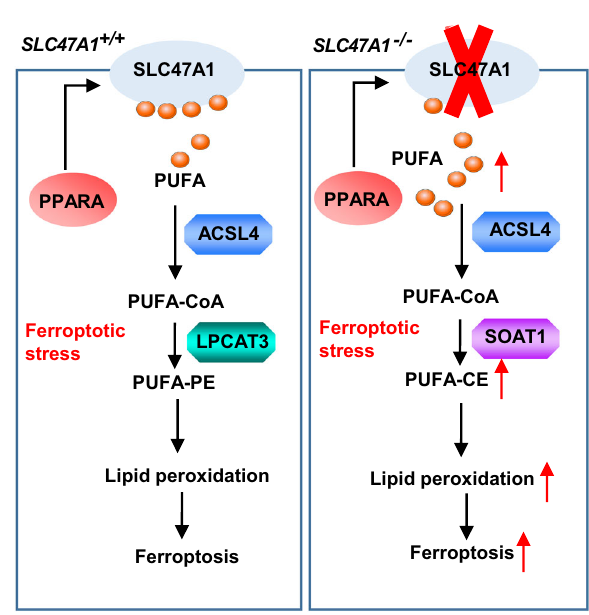
Fig. 8 | A model illustrating the metabolic role of SLC47A1 in inhibiting fer- roptosis. PPARA-mediated expression of lipid fl ipase SLC47A1 on cell membranes is a regulatoroflipid remodeling and survivalduring ferroptosis. Inwildtypecells, the ACSL4-SOAT1 pathway-mediated PUFA-CE production favors ferroptosis. In SLC47A1 de fi cient cells, the ACSL4-SOAT1 pathway-mediated PUFA-CE production promotes